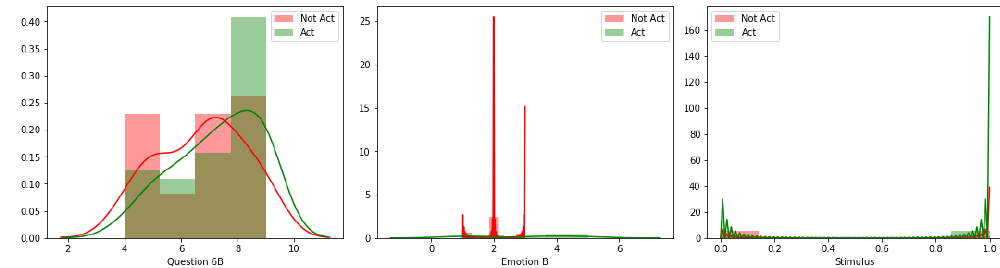
Figure 6. Distribution of variables.